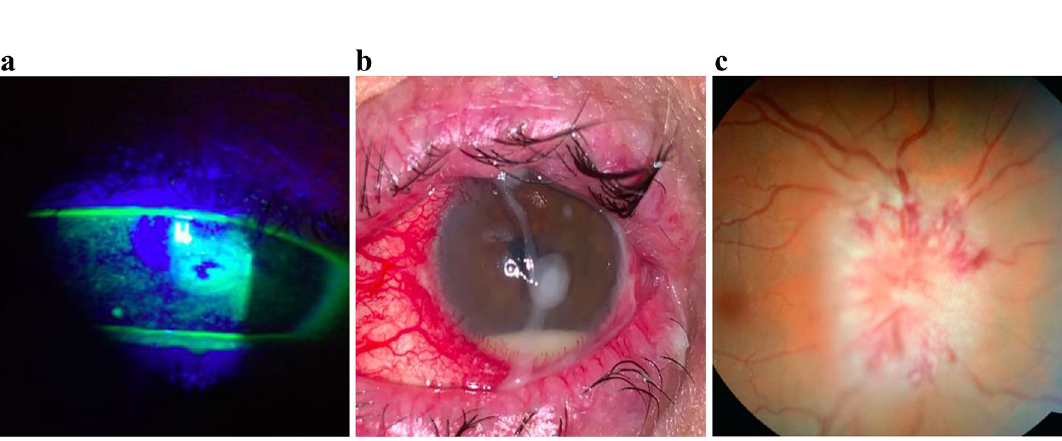
Figure 3. Ocular complications seen in patients treated in the ocular GVHD